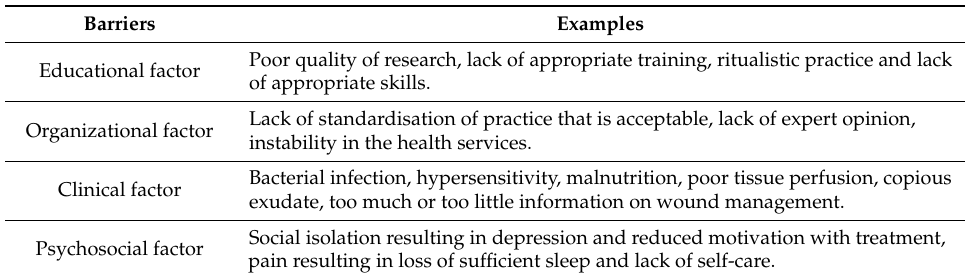
Table 1. Barriers to effective treatment of